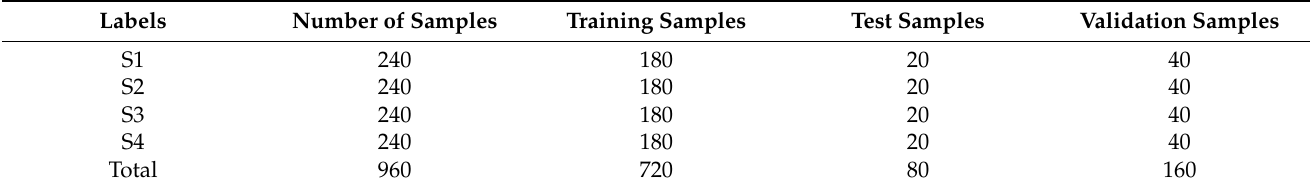
Table 5. Time – frequency plot datasets for four different fault states after WOA-VMD. Table 5. Time–frequency plot datasets for four different fault states after WOA-VMD.